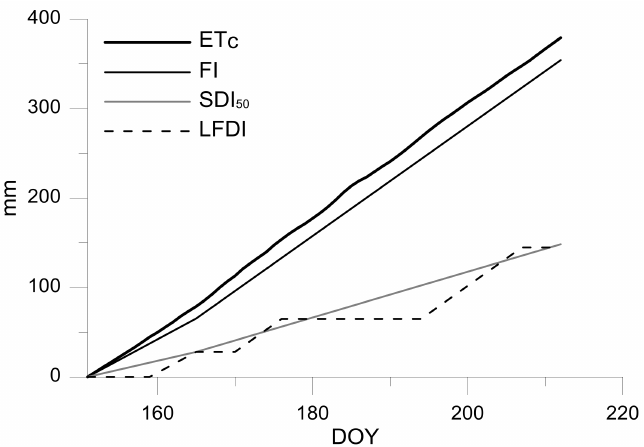
Figure 1. Accumulated crop evapotranspiration (ET C ) and irrigation doses applied. FI, full irrigated at 100% ET C ; SDI 50 , sustained deficit irrigation at 50% of ET C ; and, LFDI, low-frequency deficit